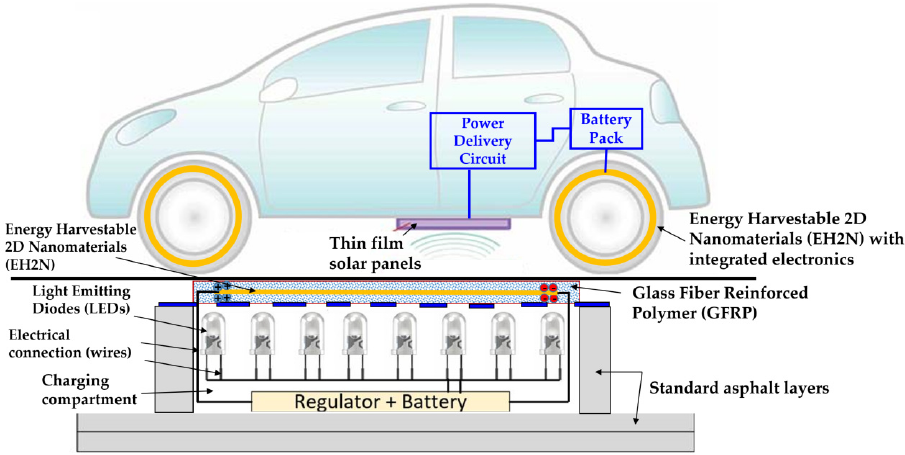
Figure 1. Schematic of the smart charging system proposed for EVs and roadway infrastructure.